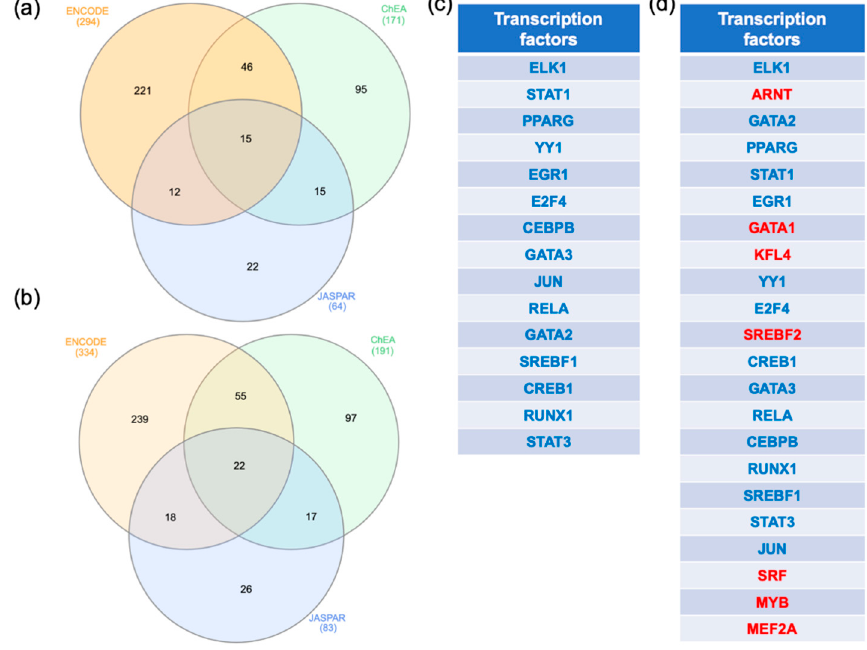
Table 2. MicroRNA analysis.